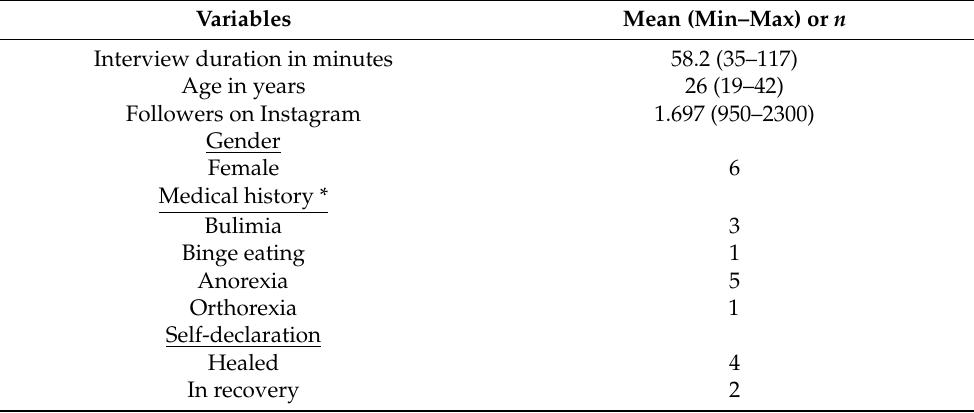
Table 1. Sample characteristics of the recovery account people ( n = 6).